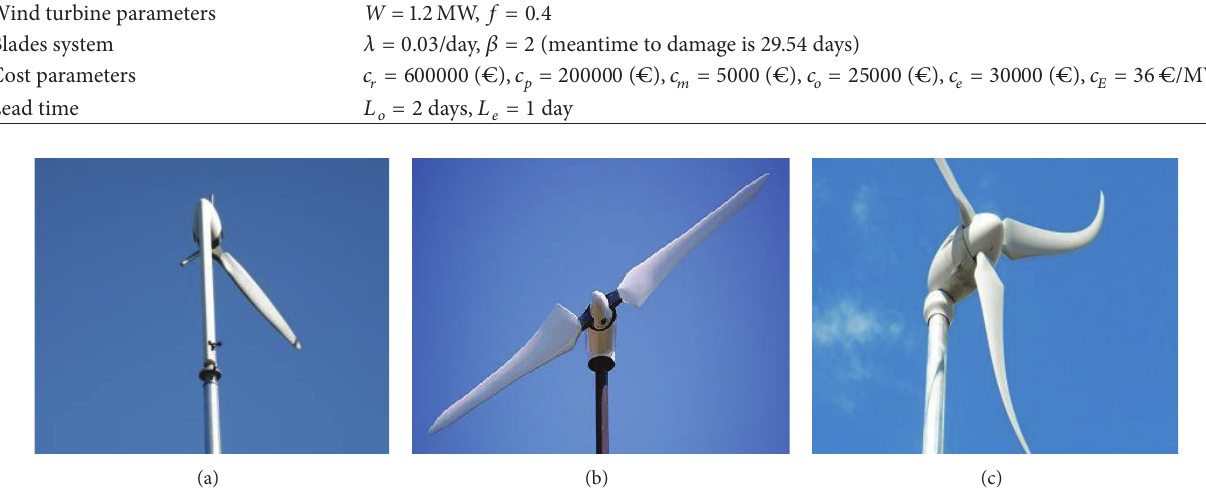
Figure 5: A blades system with (a) one blade, (b) two blades, and (c) three blades.